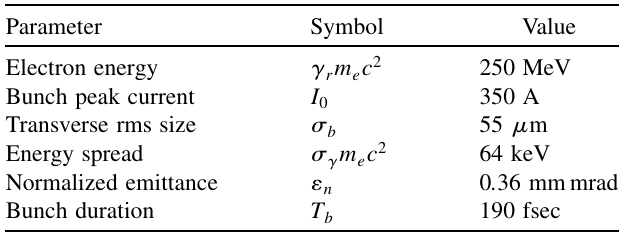
TABLE I. SwissFEL injector parameters after bunch compres- sion.